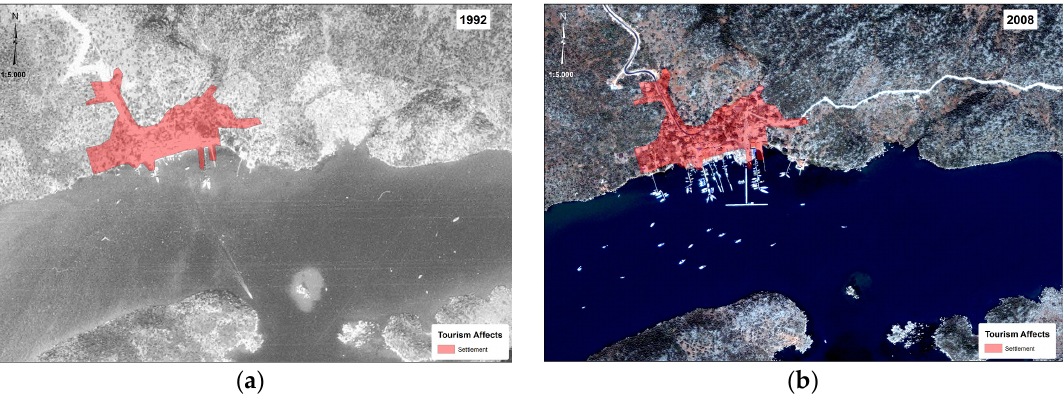
Figure 3. The changes of settlement in Kas-Kekova PA caused mainly by touristic activity that can be observed in aerial and satellite images from 1992 (a) and 2008 (b). The red polygons denote the rural settlement boundary registered by MoEU.